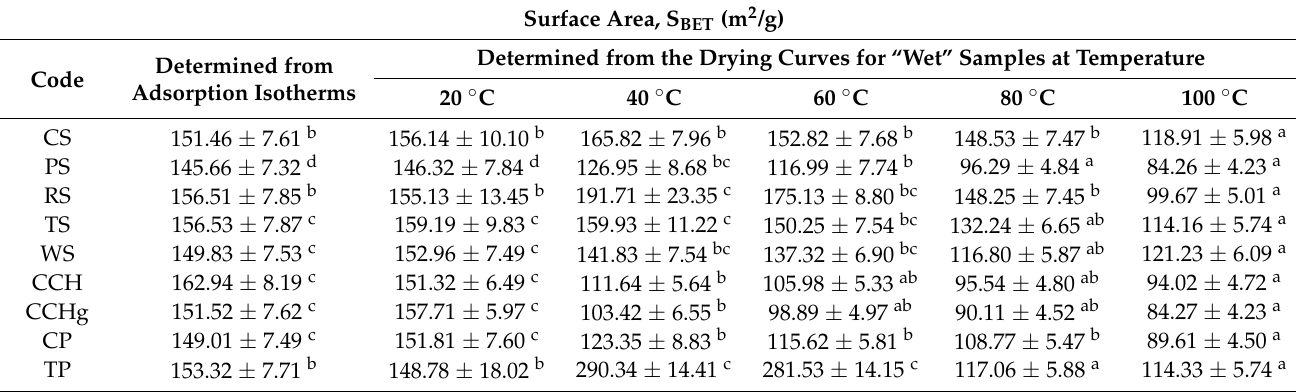
Table 3. Comparison of specific surface area determined from adsorption isotherms vs. drying curves.